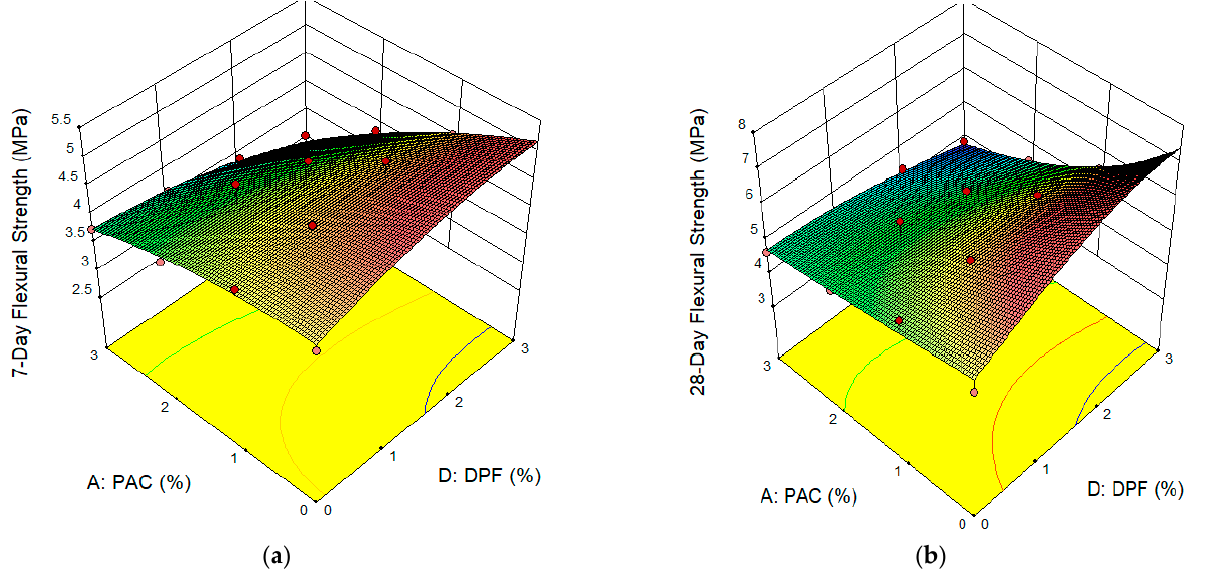
Figure 9. Surface Plots for flexural strengths. ( a ) 7-day Flexural Strength, ( b ) 28-day Flexural Strength.